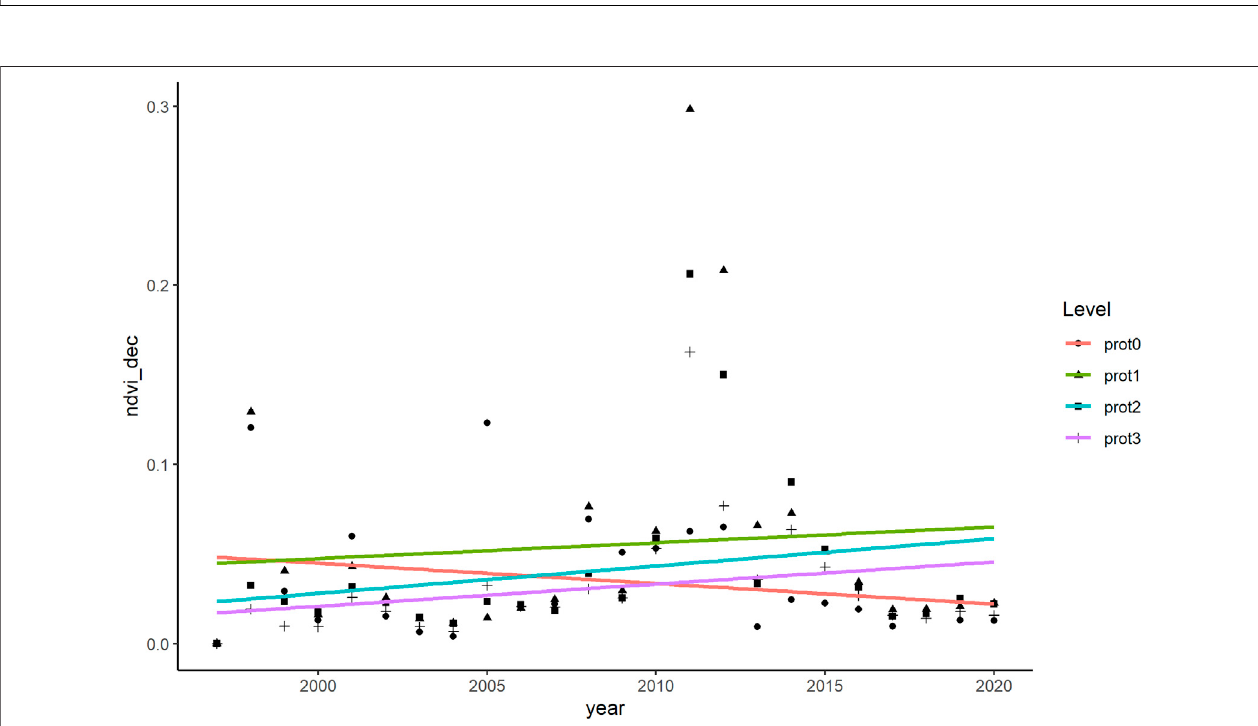
FIGURE 11 | Percent of area with a decrease in NDVI, per level of protection, over time. prot0: unprotected area, prot1: National Reserve, prot2: National Park, prot3: Strict Nature Reserve.